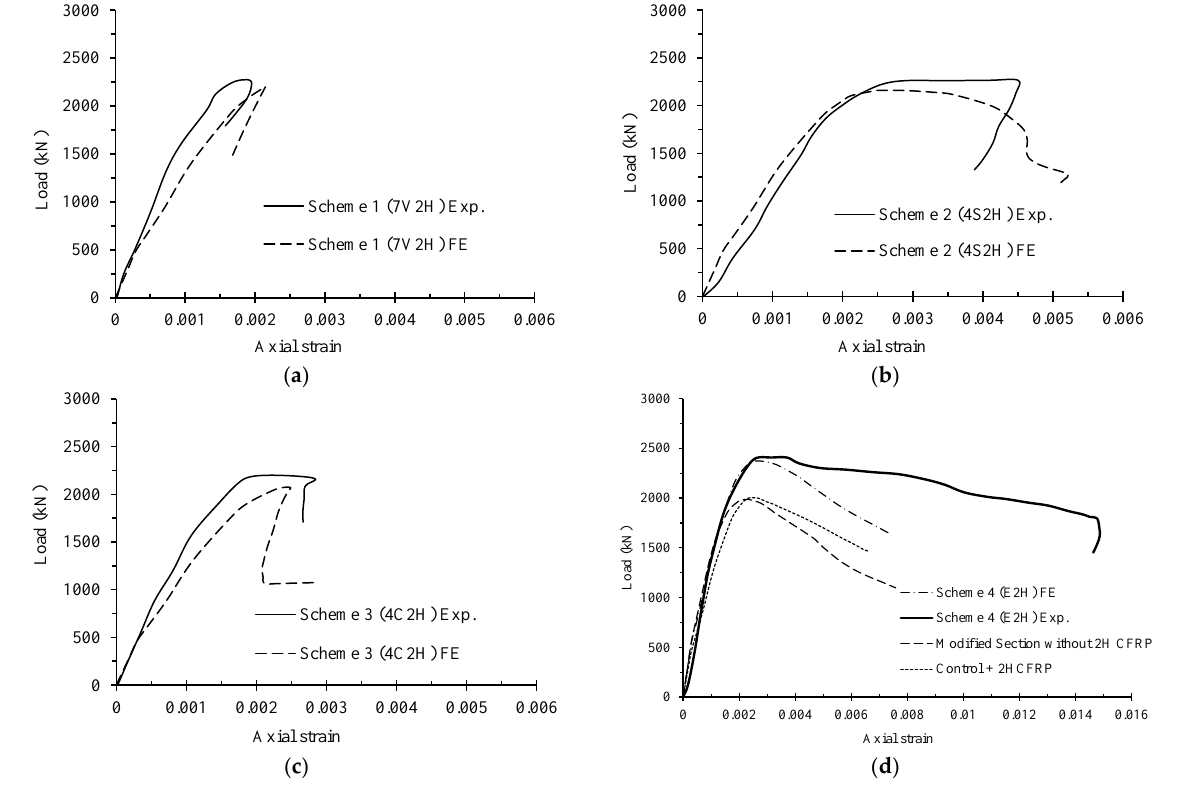
Figure 13. Comparison of experimental and numerical load versus axial strain curves for columns strengthened using: ( a ) Scheme 1; ( b ) Scheme 2; ( c ) Scheme 3; and ( d ) Scheme 4.